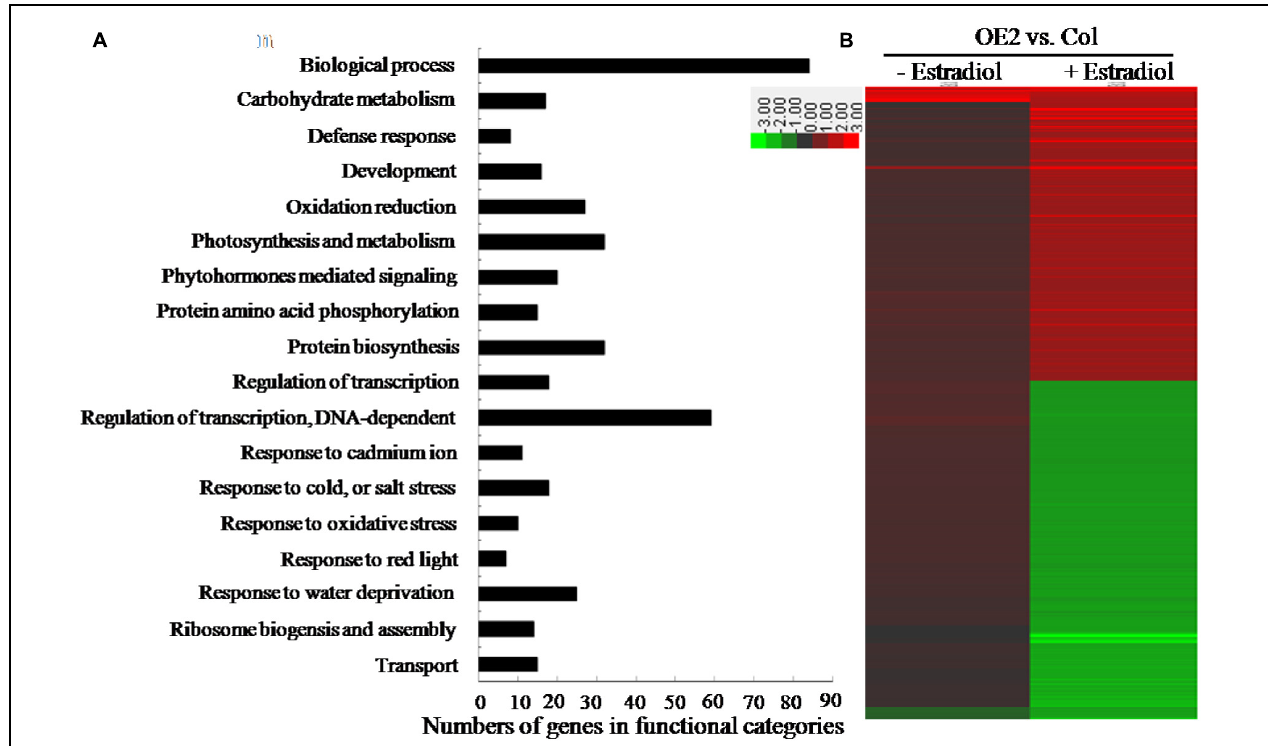
FIGURE 6 | Differentially expressed genes were identified by microarray analysis between Col and OE2 plants. The 10-day-old seedlings were pretreated with 17- β -estradiol (10 μ M) or DMSO for 24 h, respectively, and then processed for microarray analysis. (A) Profiling for the differentially expressed genes using the CapitalBio R (cid:5) Molecular Annotation System V4.0 (CB-MAS) functional catalog. Categories of the differentially expressed genes in OE2 and Col plants after 17- β -estradiol (10 μ M) treatment for 24 h. (B) Hierarchical cluster analysis of genes regulated by AtIPT8 overexpression in Arabidopsis . The differentially expressed genes in OE2 plants after 17- β -estradiol (10 μ M) induction were imported for cluster analysis by using Cluster 3.0, and the resulting tree figure was displayed using the Java Treeview software. The detailed information of genes was listed in Supplementary Table